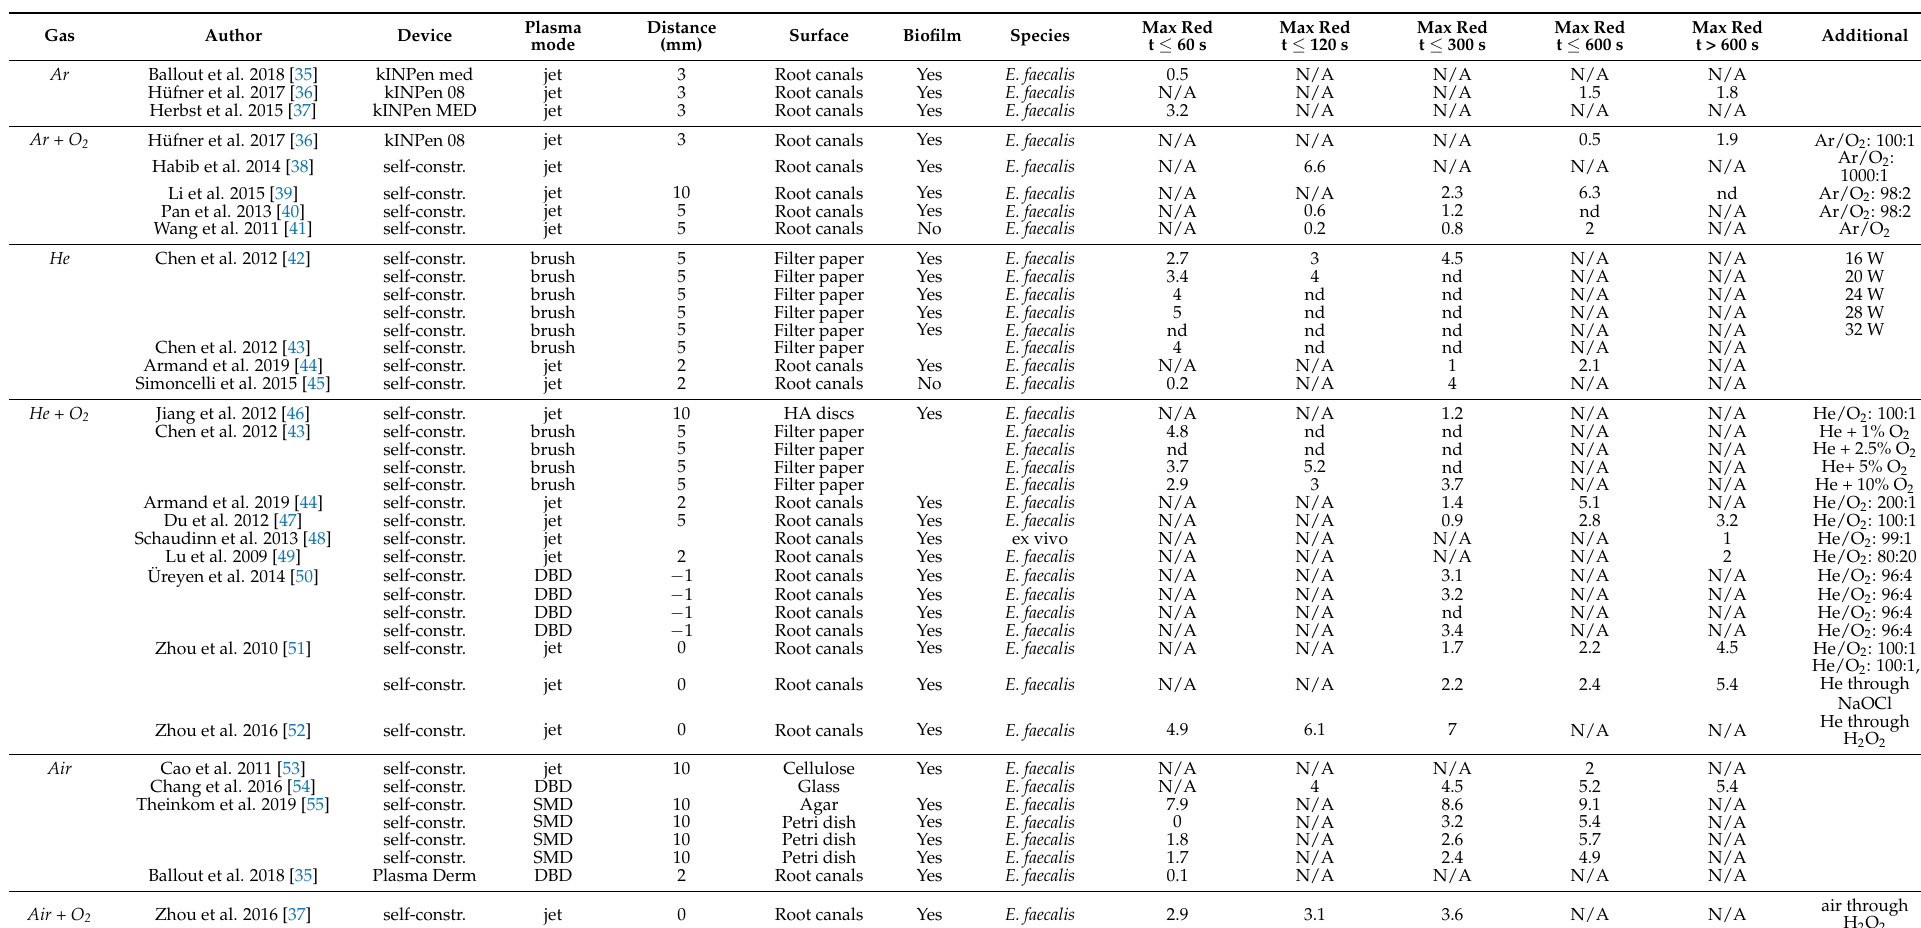
Table 3. Effect of CAP on E. faecalis ; Abbreviations: conc.: concentration; DBD: dielectric barrier discharge; HA: hydroxyapatite; H 2 O 2 : hydroxy peroxide; max red: maximal reduction; N/A: not available; NaOCl: sodium hypochlorite; nd: non-detectable; ns: non-significant; self-constr.: